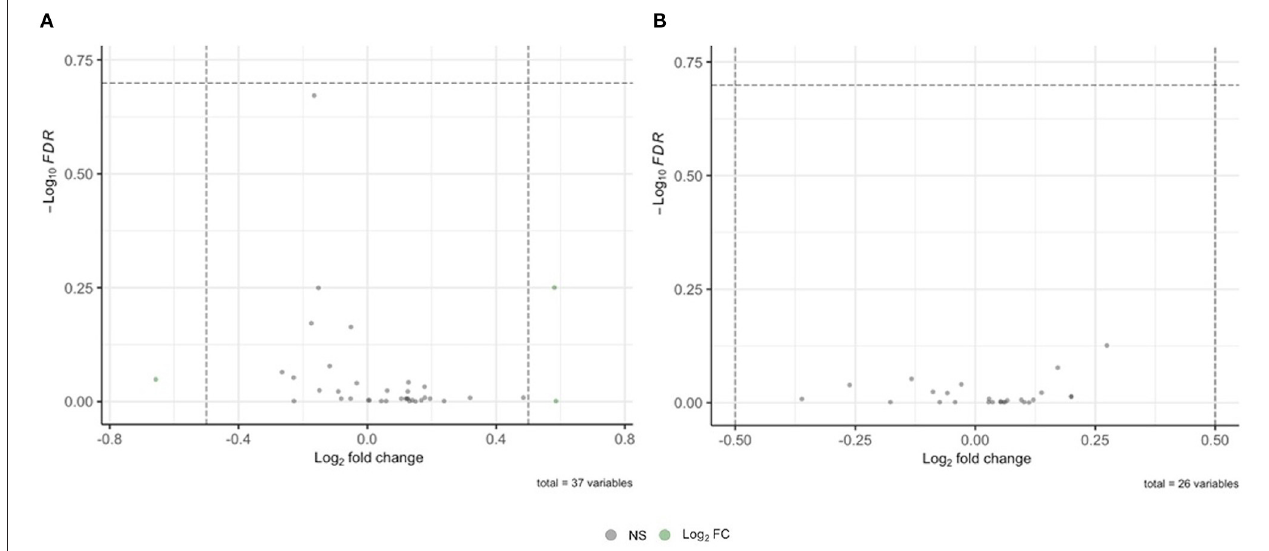
FIGURE 3 | Volcano plot of mRNA and proteins associated with fragile X mental retardation protein (FMRP) in fragile X-associated tremor/ataxia syndrome (FXTAS) cortexes. (A) No significant differences were found in proteins derived from FMRP-associated mRNA. (B) No significant differences were found in proteins derived from FMRP-associated proteins.